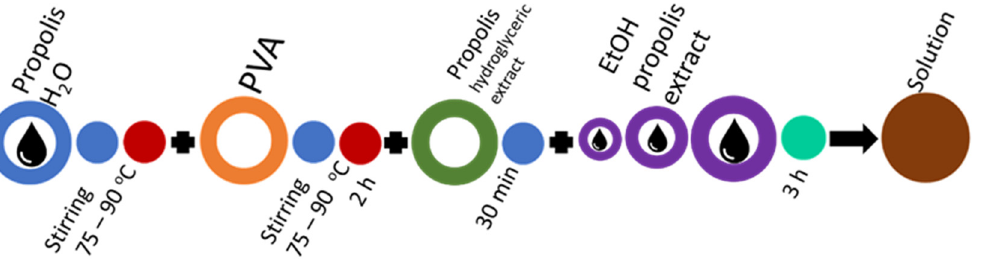
Table 9. Electrospinning solutions with propolis